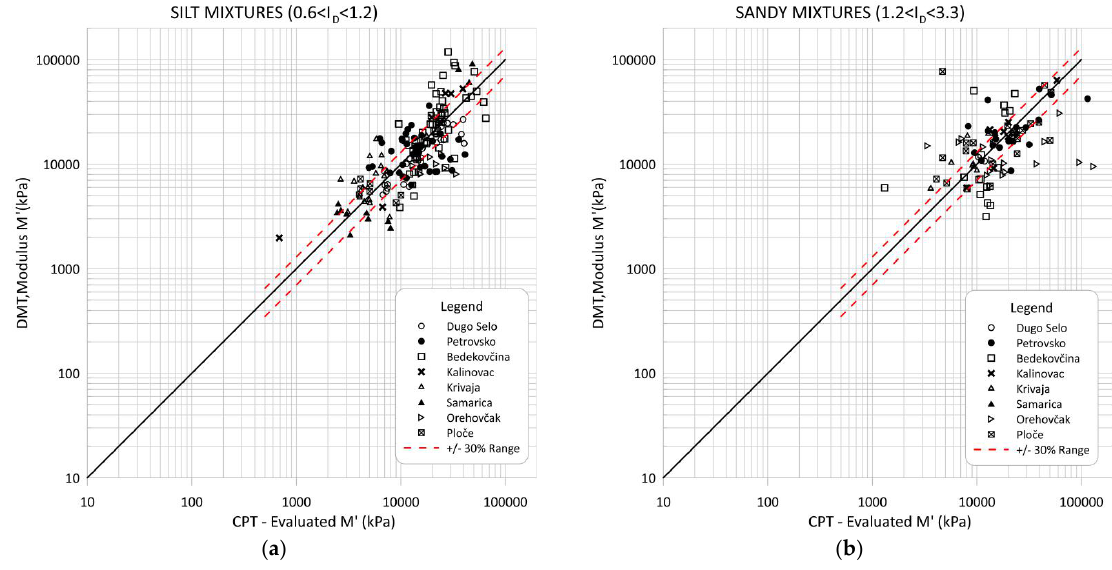
Figure 15. Comparison of CPT evaluated M’ through correlations and constrained modulus M’ DMT from dilatometer data: ( a ) all soils; ( b ) clays.